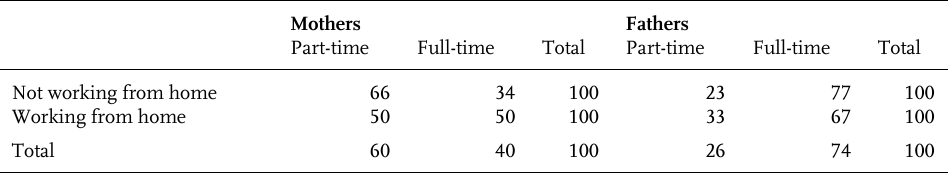
Table A5: Employment by working from home, April and May 2020, in % Mothers